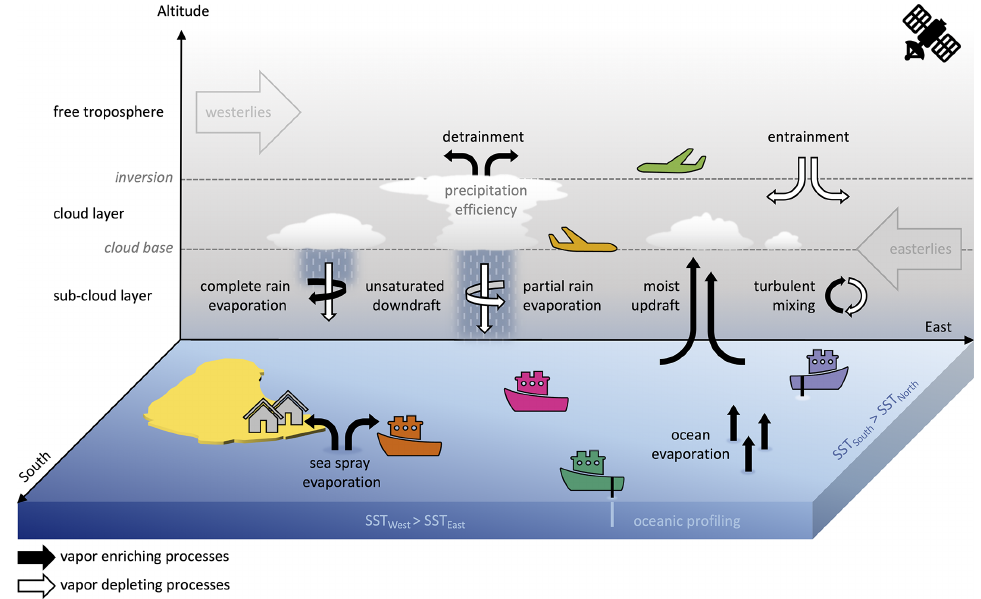
Figure 1. Examples of moist processes that influence the water vapor isotopic composition of the trade-wind environment around Barbados (yellow landmass) and that can be studied using the EUREC 4 A-iso dataset collection. Black arrows indicate processes expected to increase water vapor isotope ratios, while white arrows indicate processes expected to lower them. The ships and aircraft in the schematic represent the six mobile EUREC 4 A-iso in situ sampling